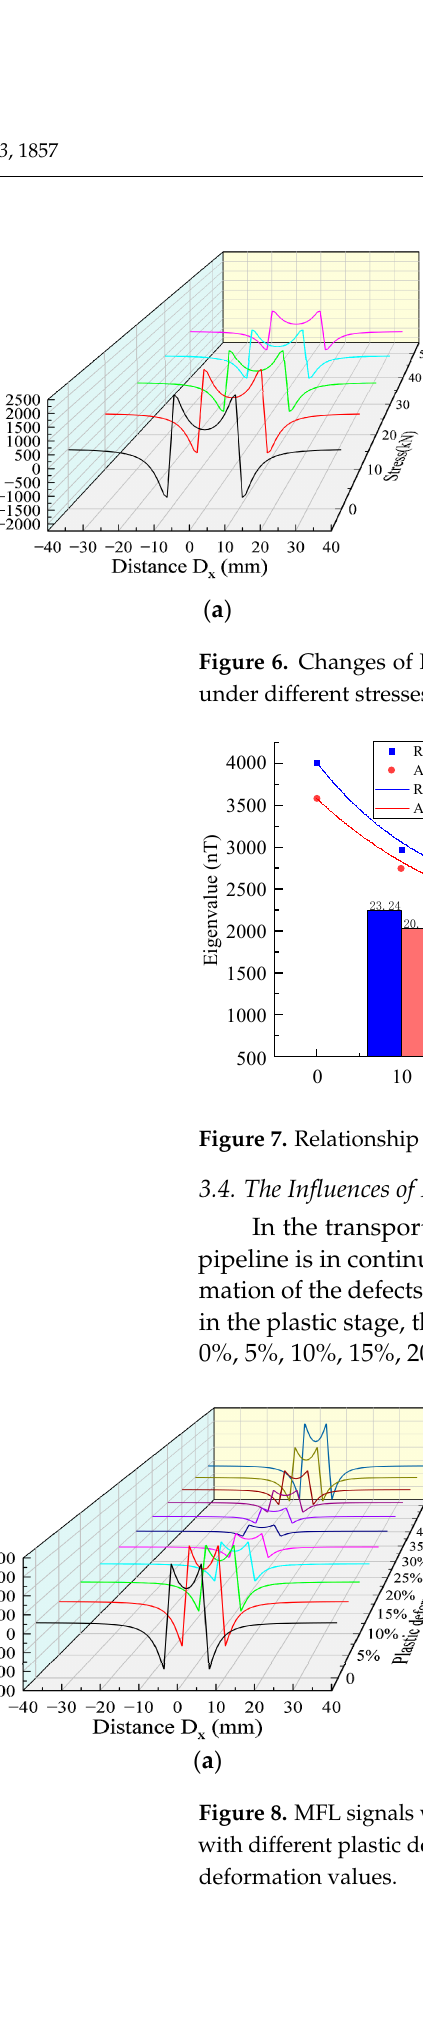
Figure 8. MFL signals with different plastic deformation values. ( a ) Axial component of MFL signals with different plastic deformation values. ( b ) Radial component of MFL signals with different plastic deformation values. With the increase in the plastic deformation, the MFL signals presented an upward trend, followed by a downward trend. The eigenvalues of the axial and radial components in the plastic deformation were extracted (Figure 9).